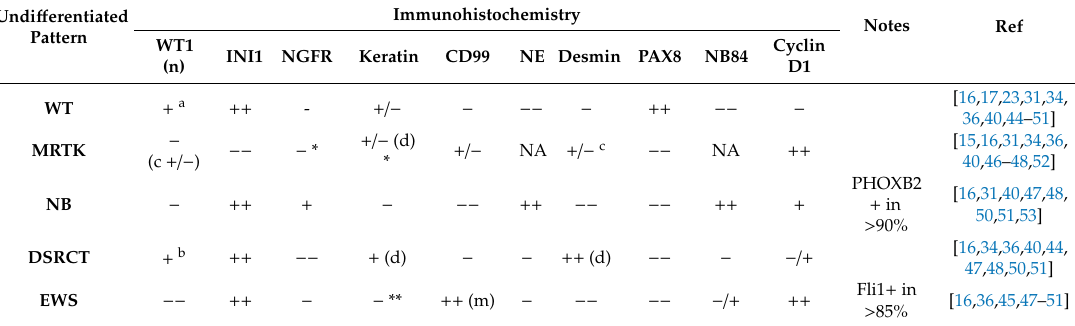
Table 4. The immunohistochemical characteristics of the most common pediatric tumors with an undi ff erentiated